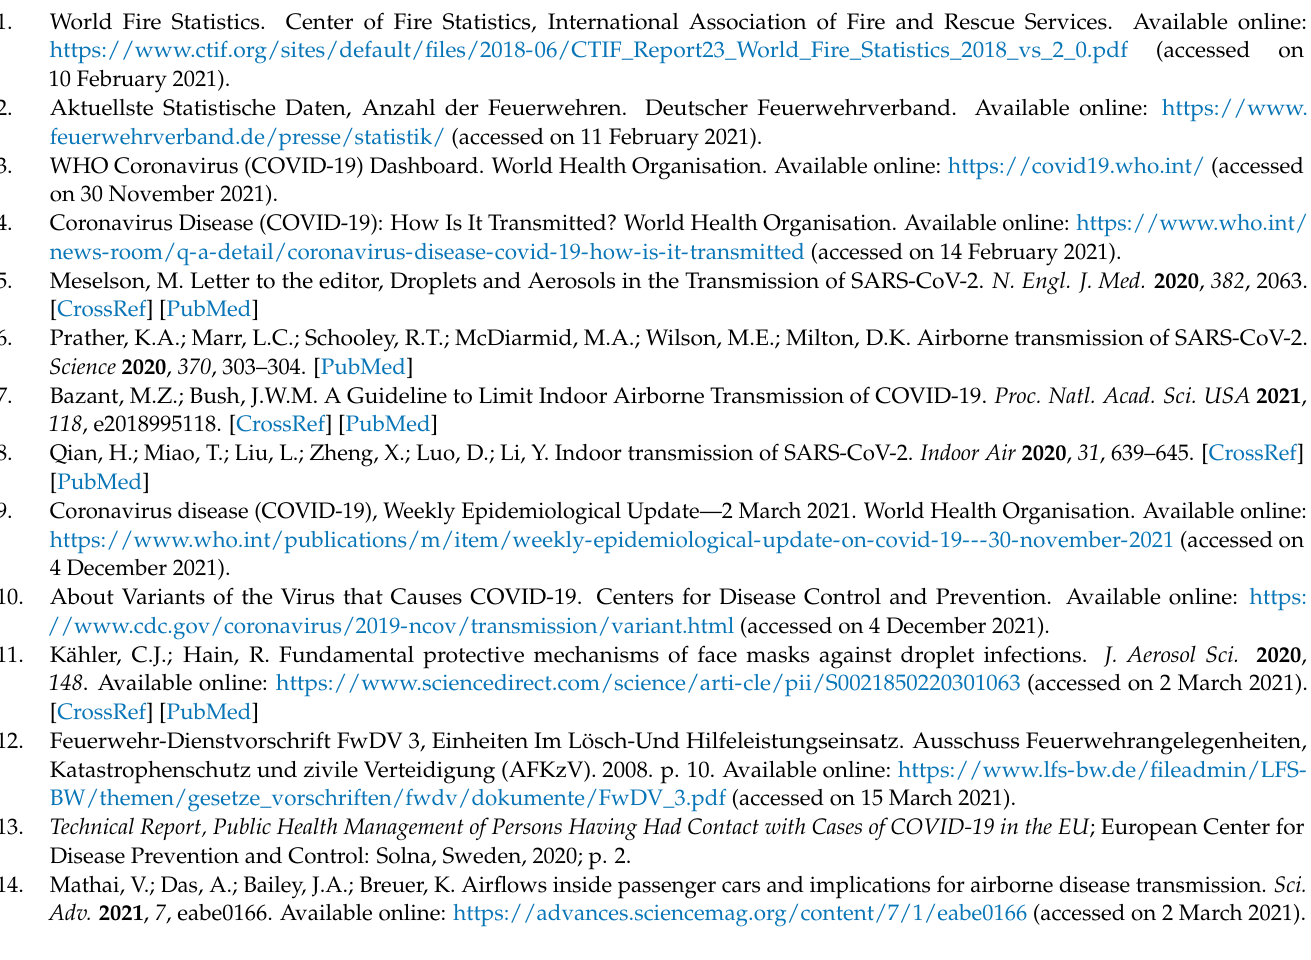
Figure A2. Total aerosol burden measured from minute 11 to 15.